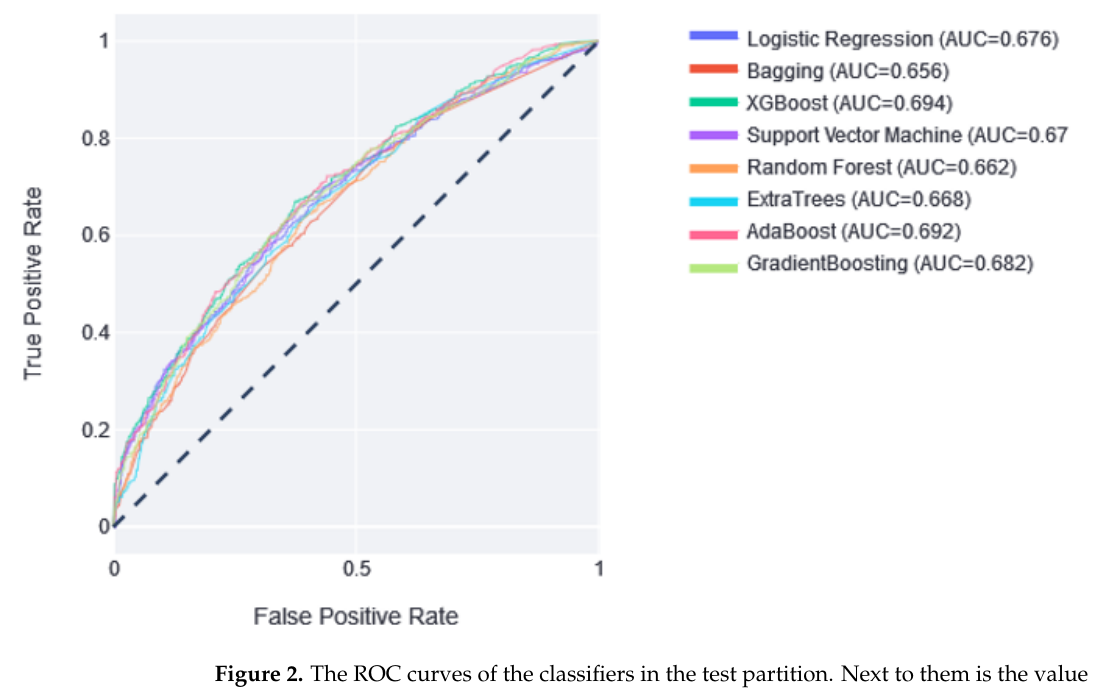
Figure 2. The ROC curves of the classifiers in the test partition. Next to them is the value of the area under this curve. Dotted line represents AUC value of 0.5, which means random prediction.